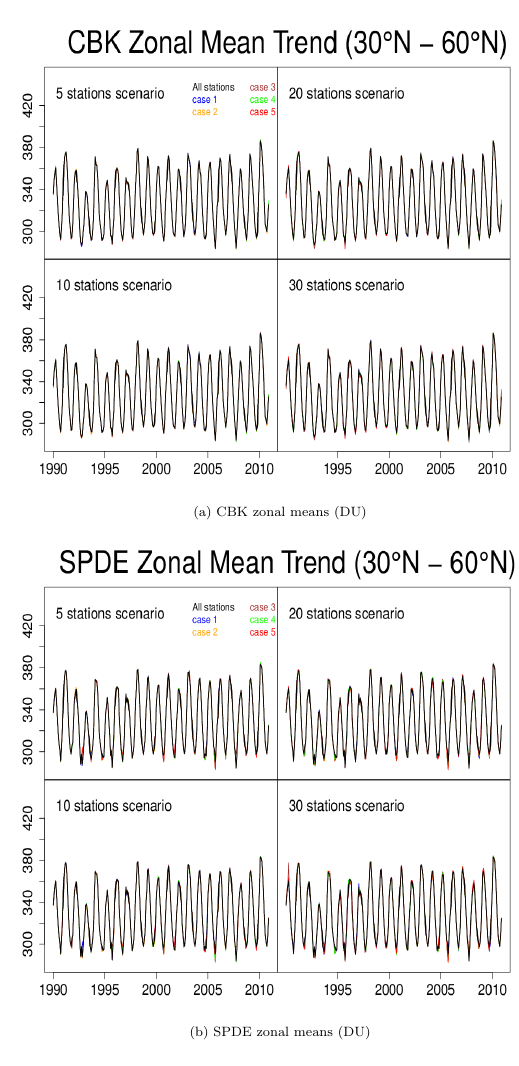
Figure 12. Time series of 30–60 ◦ N zonal means by (a) covariance- based kriging (CBK) and (b) SPDE from 1990 to 2010 for four scenarios with 5, 10, 20 and 30 stations drifted